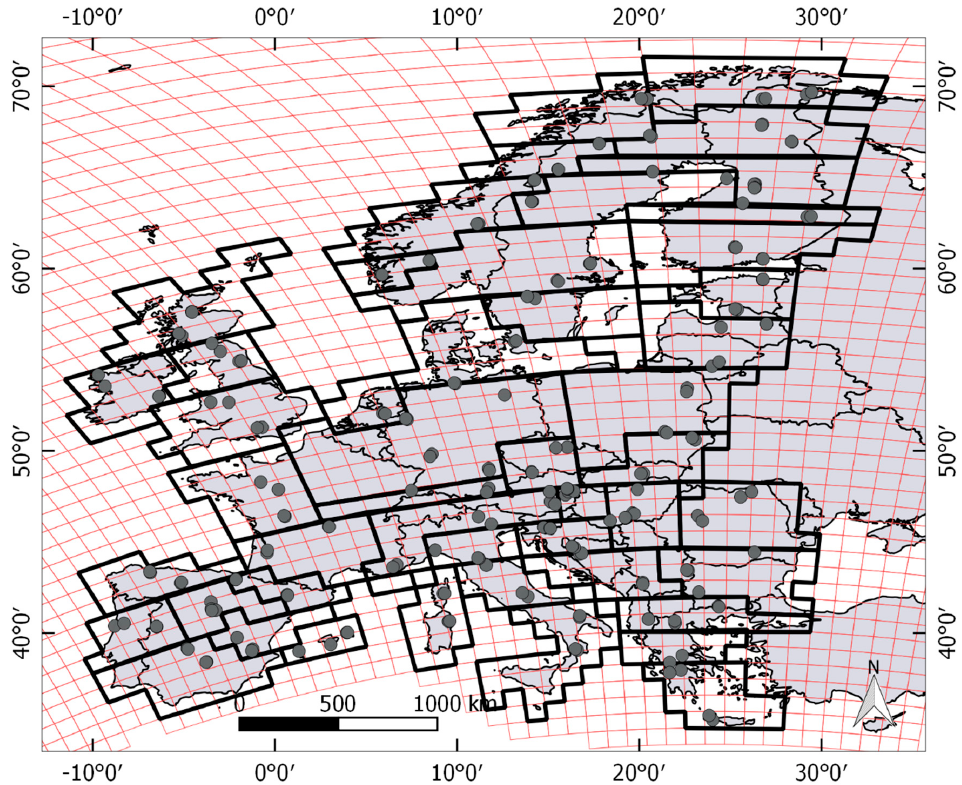
Figure 3. Overview of the regions used for the Sentinel-1 forest maps computation (black lines) and the locations of their respective signature prototypes (grey points) across Europe. Red lines indicate the Equi7 grid tiling.